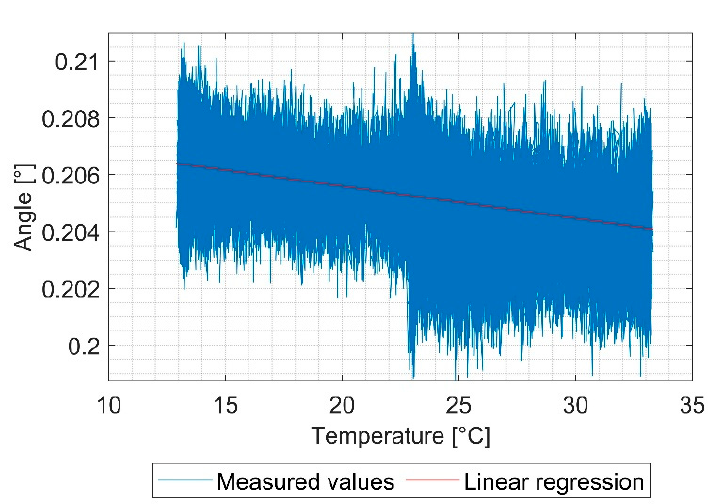
Figure 10. Temperature stability with linear regression with the method of least squares.